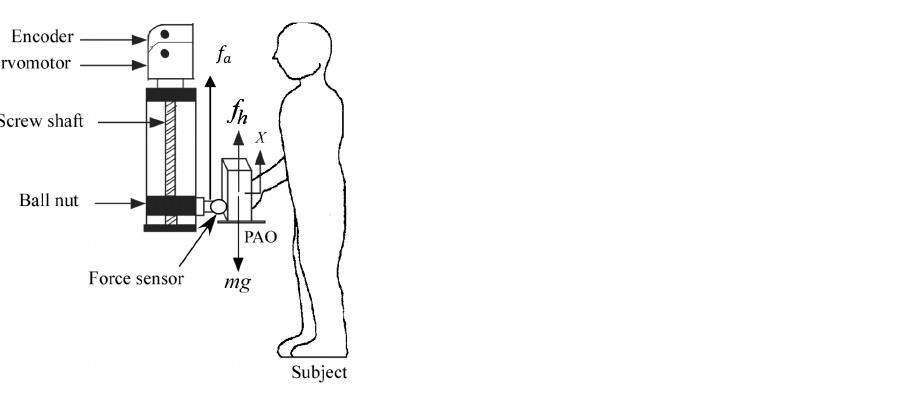
Figure 4. The dynamics of lifting a PAO with the power assist robotic system by a subject (human user).